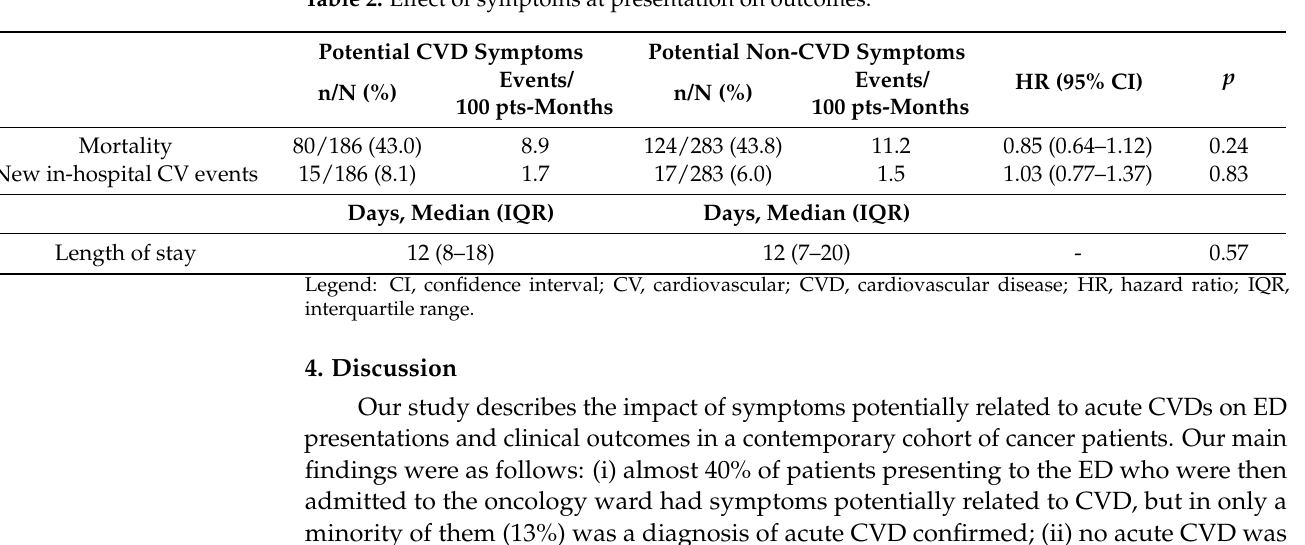
Figure 3. Cumulative incidence of all-cause death according to symptoms at presentation estimated using the Kaplan–Meier method. CVD, cardiovascular disease. Table 2. Effect of symptoms at presentation on